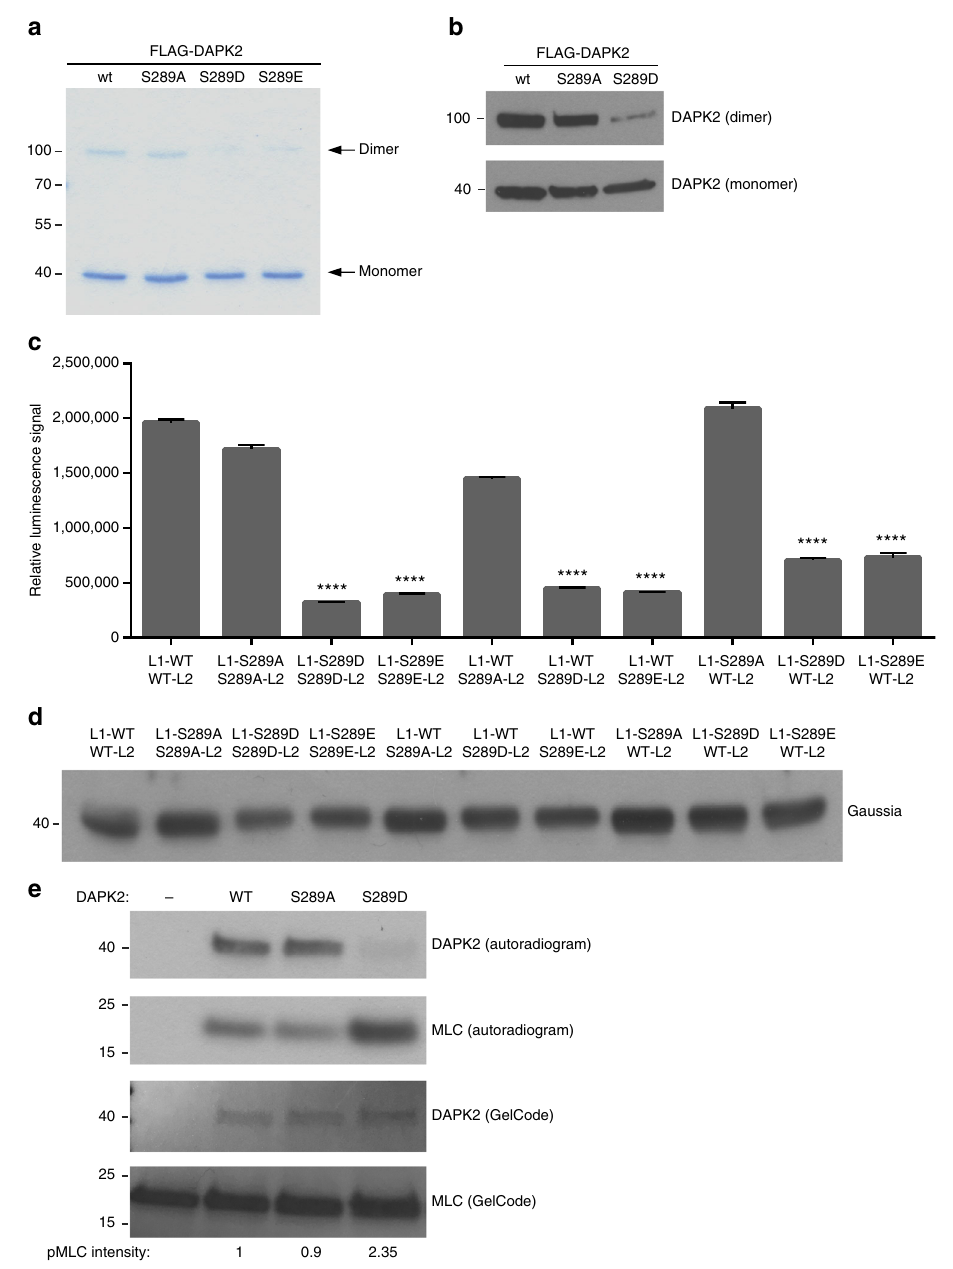
Fig. 5 Ser289 phosphorylation reduces dimerization and autophosphorylation. a FLAG-DAPK2 WT and mutants were overexpressed in HEK293T cells and immunoprecipitated using anti-FLAG antibody. Immunoprecipitated protein was resolved by SDS-PAGE and the gel was stained with GelCode Blue. A representative gel of three independent experiments is shown. b FLAG-DAPK2 WT and mutants were overexpressed in HEK293T cells and resolved by SDS – PAGE. The upper part of the membrane, corresponding to the DAPK2 dimer size, was reacted with anti-FLAG antibody diluted 1:1000, and the lower part of the membrane, corresponding to the DAPK2 monomer size, was reacted with anti-FLAG 1:500,000. A representative immunoblot of three independent experiments is shown. c HEK293T cells were transfected with different combinations of L1 and L2-fused DAPK2 WT and mutants, and luminescence was measured. Bar graph represents dimerization level as mean ± SD of three technical repeats. Statistical analyses were performed using one-way ANOVA with post hoc Dunnett ’ s multiple comparison test. **** P < 0.0001 indicates signi fi cant decrease in dimerization of all DAPK2 pairs containing a S289D/S289E mutant compared to WT. d Expression of the different constructs was assessed using anti-gaussia luciferase antibody that detects both L1 and L2 on western blot. e FLAG-DAPK2 WT, S289A or S289D was incubated with MLC in a kinase reaction mixture containing 32 P-labeled ATP. Reactions were resolved by SDS – PAGE and exposed to X-ray fi lm. pMLC band intensity was quanti fi ed using NIH ImageJ effect of CaM binding and oppose the effect of Ser308 active conformation of the kinase. On the other hand, autopho- phosphorylation. To this end, HEK293T cells were transfected sphorylation of Ser308 secures the docking of the CaM binding with an S308D or an S289D S308D double mutant, together with domain in the catalytic cleft 12 . The fi nding that the S289D mutant does not depend on CaM for activation prompted us to test GFP. Upon overexpression, the S308D phosphomimetic mutant whether Ser289 phosphorylation may functionally mimic the was completely silent and did not induce any membrane blebbing